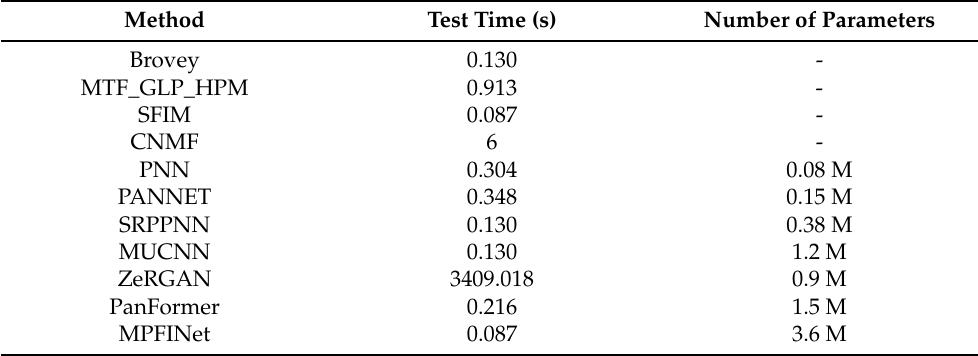
Figure 13. Visualization of feature maps. Table 9. Parameters and average test time of different